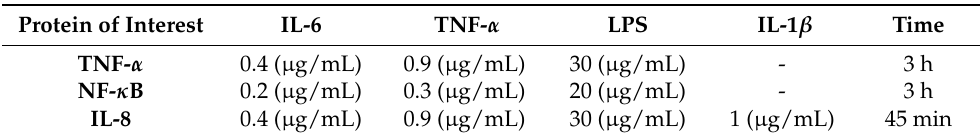
Table 1. Pro-Inflammatory Cytokines Cocktail (PIC) Concentrations Added for the Induction of Inflammation in CACO-2 Cells to Study the Expression of Nuclear Factor Kappa B cell (NF- κ B), Tumor Necrosis Factor (TNF)- α , and Interleukin (IL)-8. Protein of